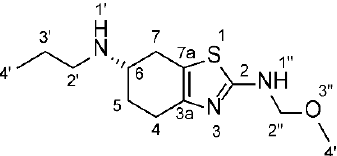
Figure 3. Chemical structure of the synthesized impurity (( S )- N 2 -(Methoxymethyl)- N 6 -propyl-4,5,6,7-tetrahydro-1,3-benzothiazole-2,6-diamine.